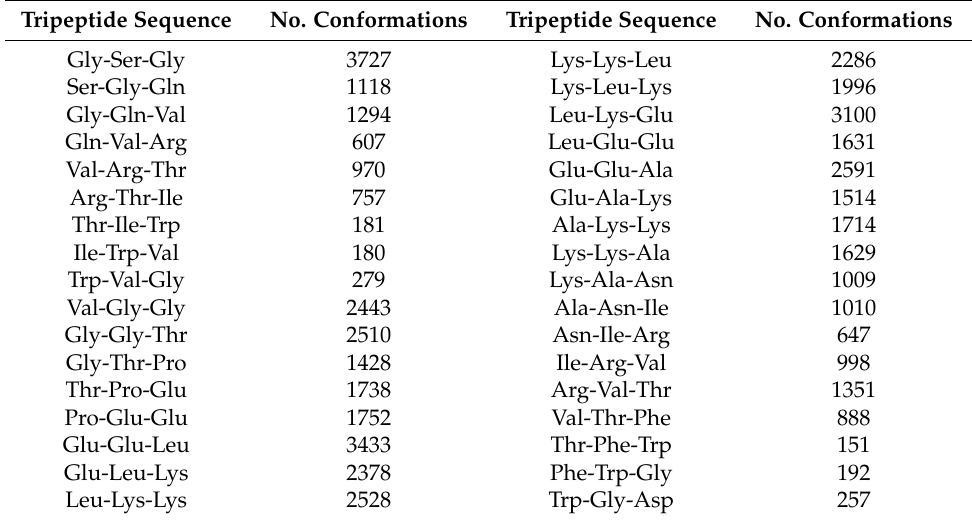
Table 4. Number of conformations (i.e., number of values of state variables) for the eight overlapping tripeptides composing